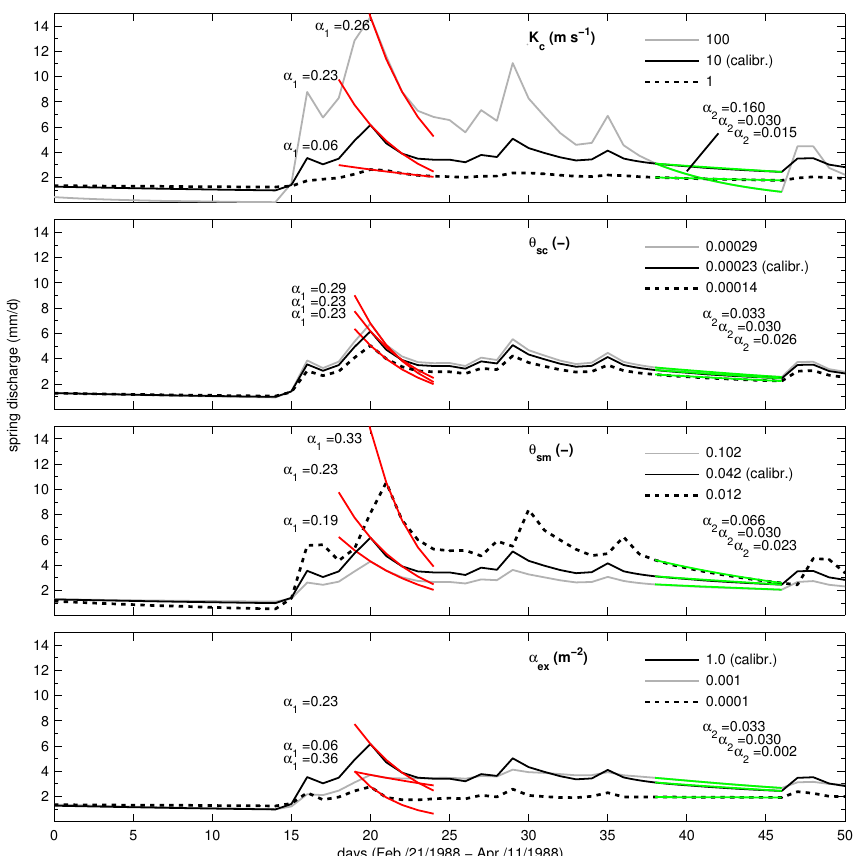
Fig. 7. Variation of hydraulic parameters ( K c , θ sc , θ sm ) and the exchange parameter ( α ex